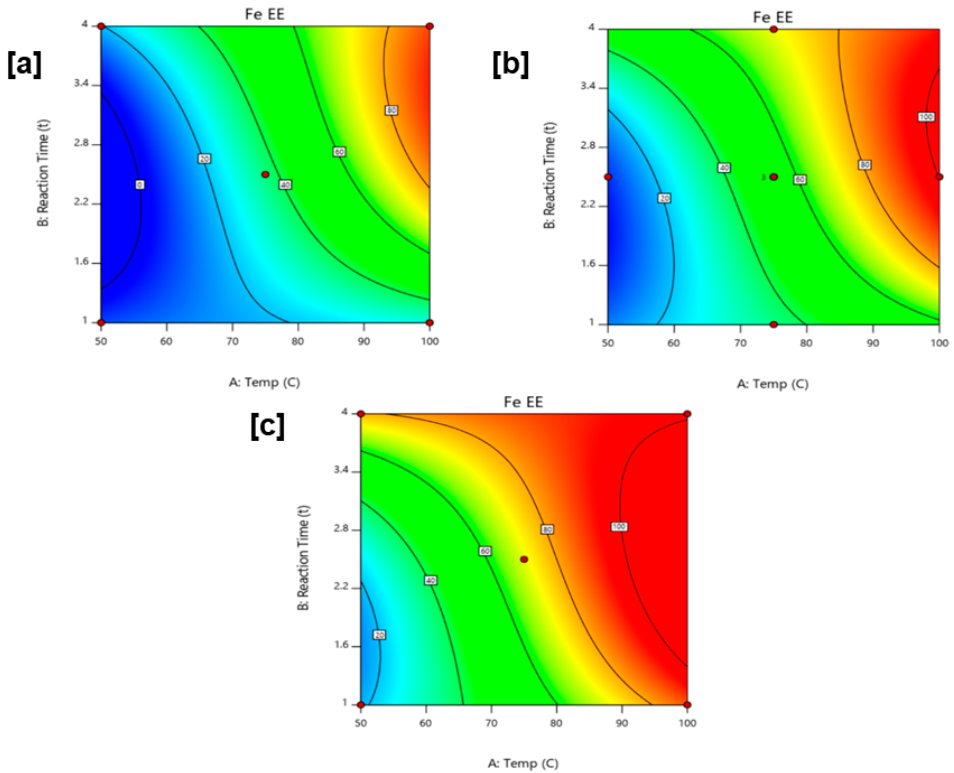
Figure 6. Contour plots of reaction time vs. temperature at ( a ) low, ( b ) mid, and ( c ) high reagent concentration levels.